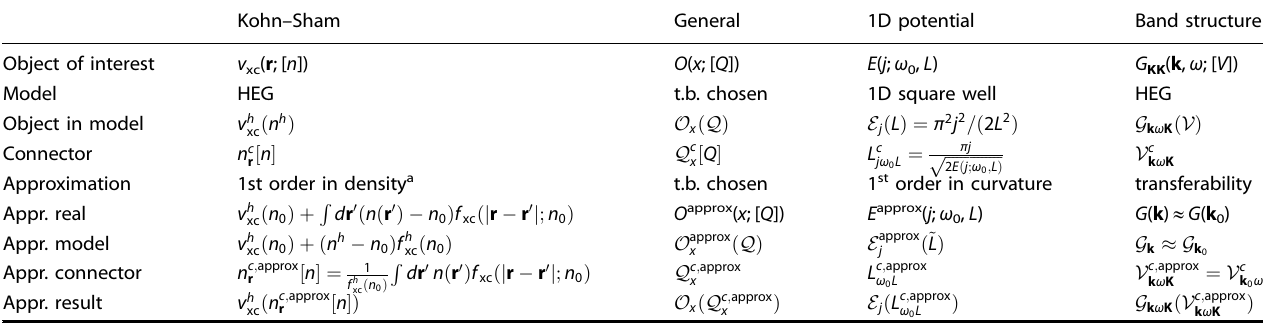
Table 1. Summary of the general COT approach and its